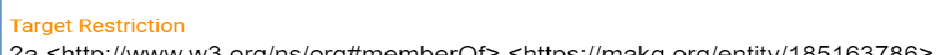
Figure 4. Using target restriction to limit the link.